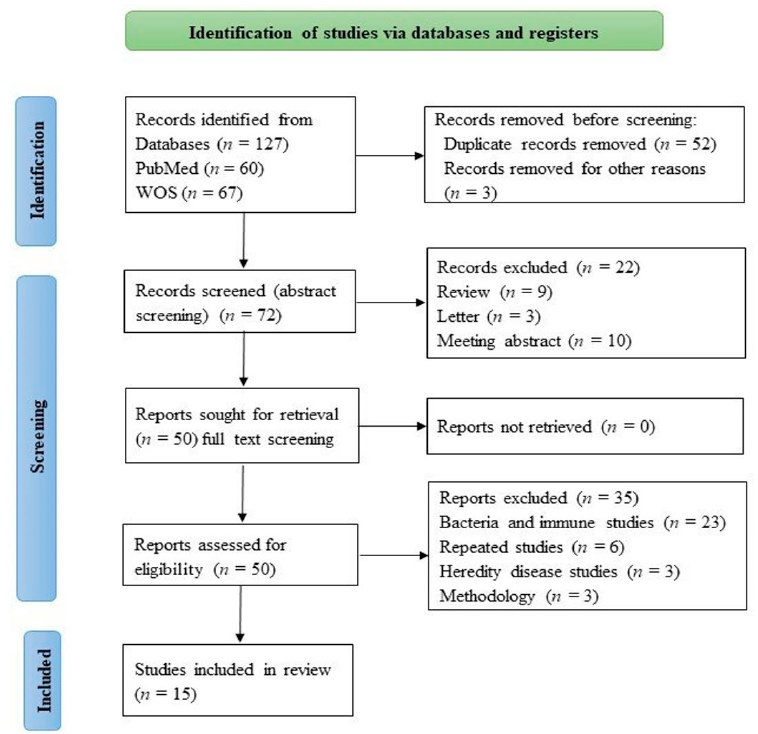
Figure 1. PRISMA flowchart on studies for systematic review.